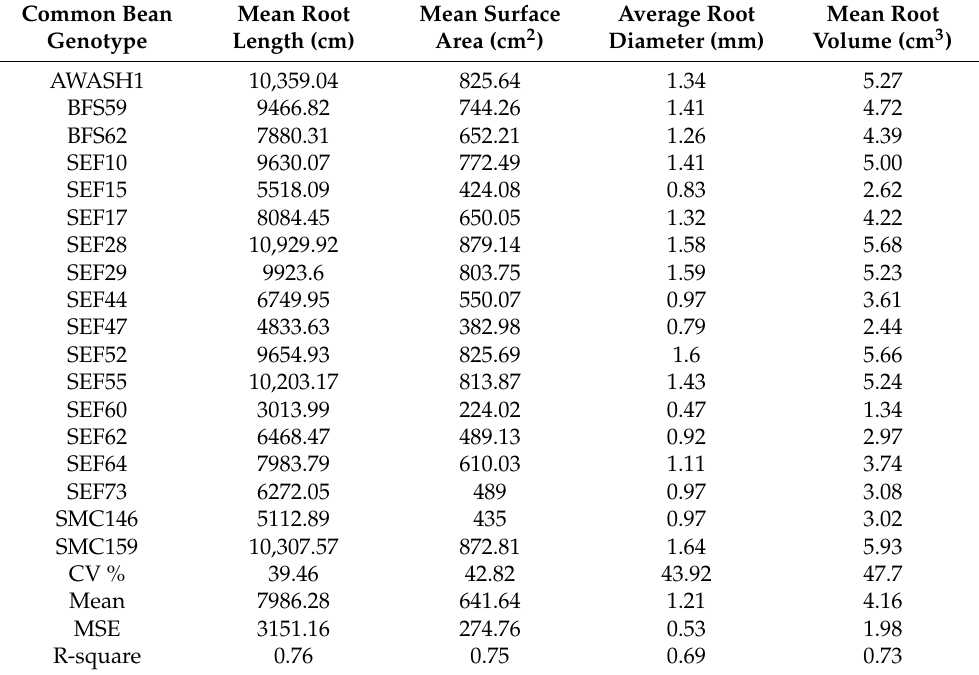
Table 14. Response of root characteristics of seed-podded, drought-tolerant common bean genotypes measured using WinRhizo under phosphorus and moisture treatments during terminal